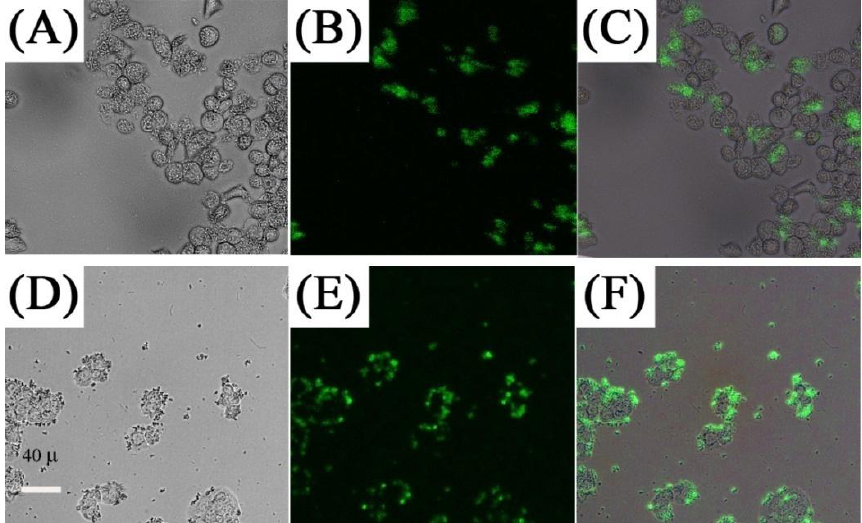
Figure 11. In vitro imaging using folic acid modified PEI/NaYF row shows the bright field ( A ), confocal ( B ), and superimposed images of live human ovarian carcinoma cells (OVCAR3) ( C ) and the bottom ( E , F ) human colonic adenocarcinoma cells (HT29) ([71], reproduced by permission of